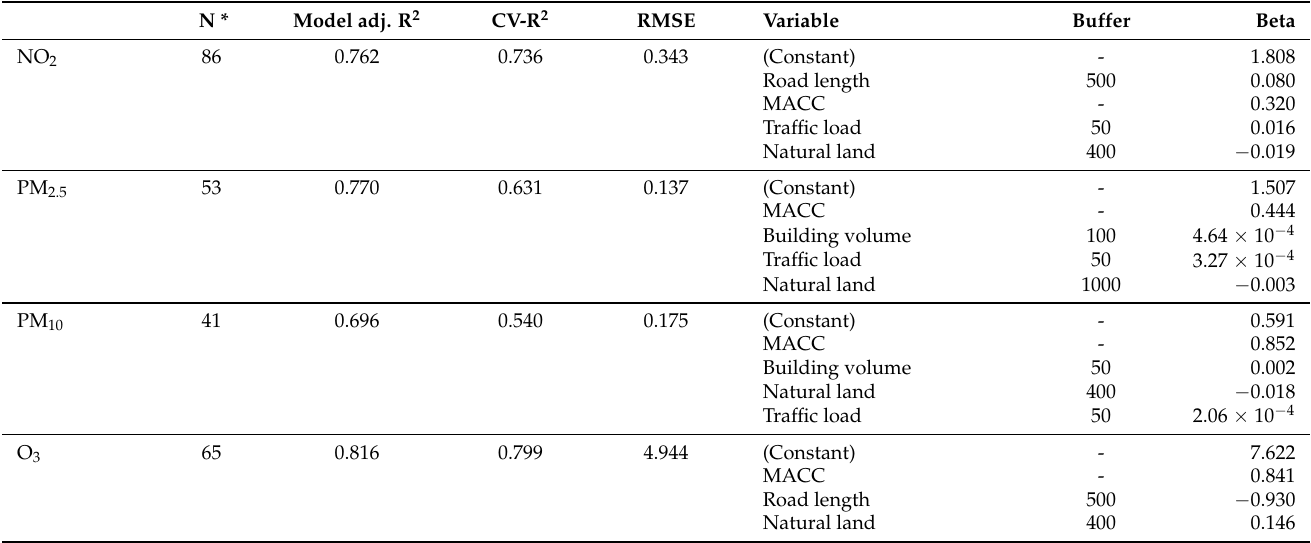
Table A1. Summary statistics for pollution concentrations obtained using LUR models.